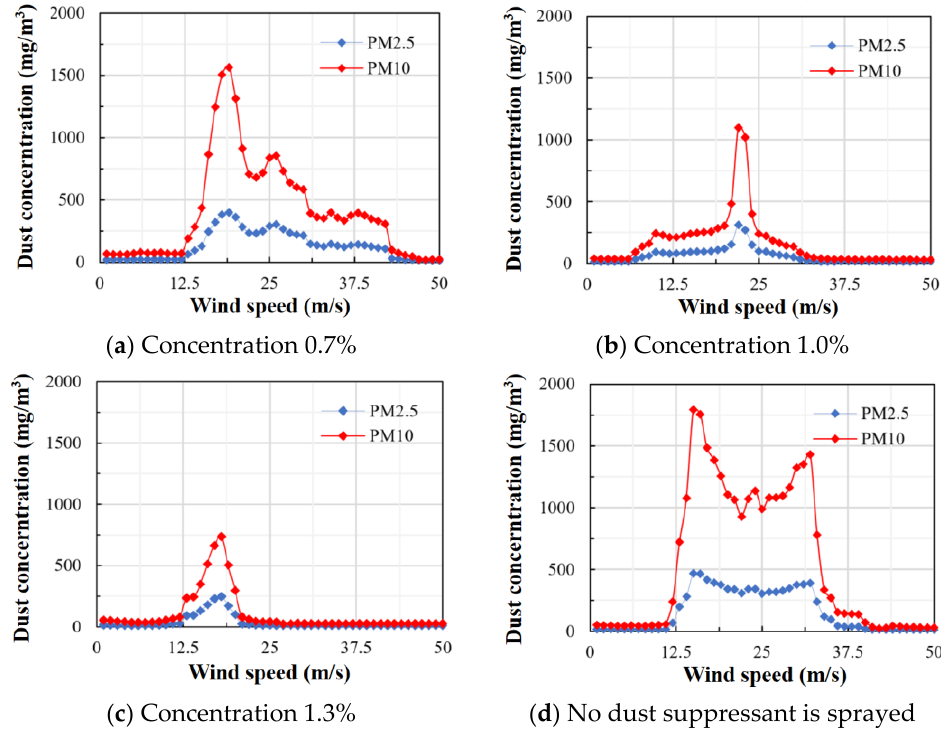
Figure 10. Dust concentration at different dust suppressant concentrations.